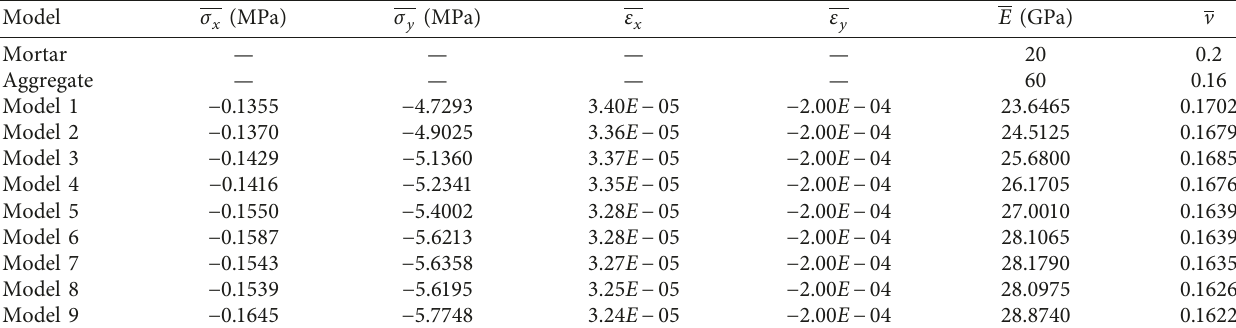
Table 3: Macroscopic elastic modulus and Poisson’s ratio of stochastic mesoscopic concrete model. Model